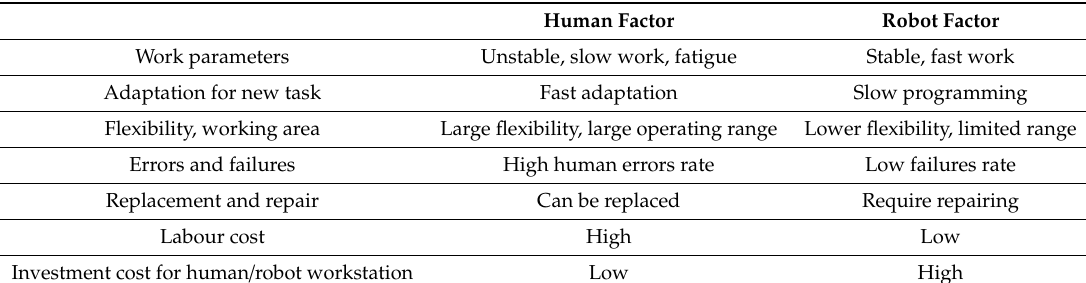
Table 1. Human and robot factors in the production